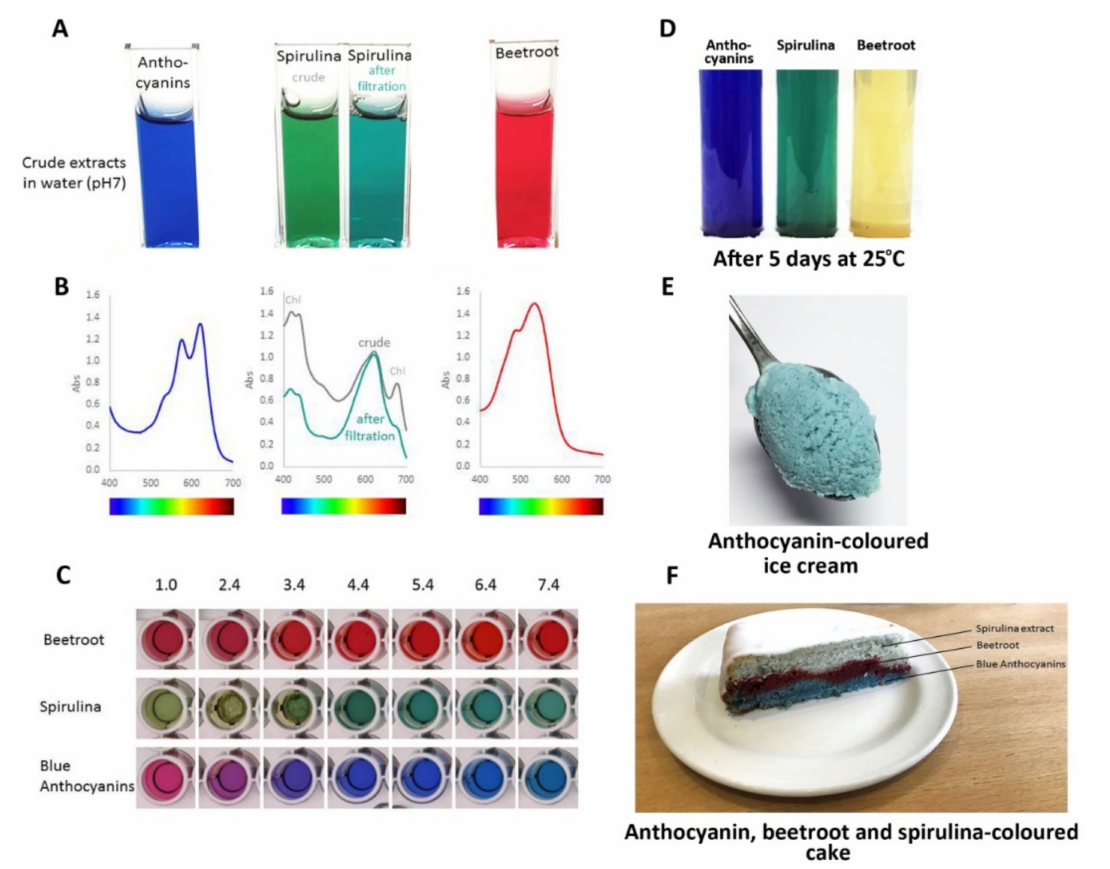
Figure 17. Comparison of performance of natural colours from different botanical sources: blue from flowers of butterfly pea, commercial natural “blue” from spirulina, and red from beetroot. ( A ) The colours of these colourants following fresh extraction/preparation in water at pH 7.0. The spirulina extract changed colour slightly following filtration to remove non- water-soluble material. ( B ) The visible absorption spectra of these colourants. Filtering of the spirulina extract removed some of the material absorbing at shorter wavelengths. ( C ) The effect of pH on the three colourants. The blue anthocyanins from butterfly pea did not maintain their “blueness” below pH 3.0, but provided strong blues over the range pH 3.0–8.0. ( D ) Stability of colours following the storage of fresh extracts at room temperature for 5 days. The red colour conferred by the betacyanins of beetroot showed poor stability. ( E ) Blue ice cream coloured by an extract from flowers of butterfly pea. ( F ) The effects of cooking on colour stability. The colour of the spirulina extract was particularly sensitive to high